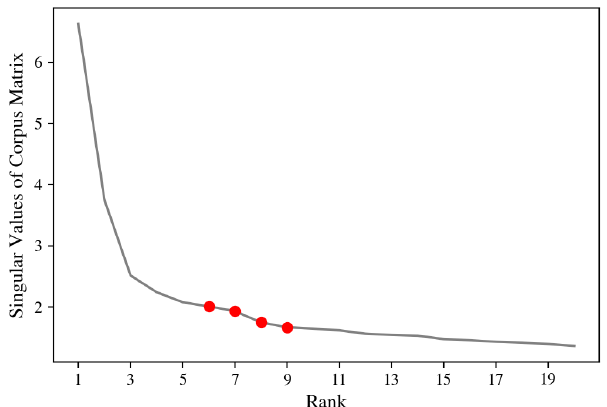
Figure 1. First 20 singular values of the CIP corpus